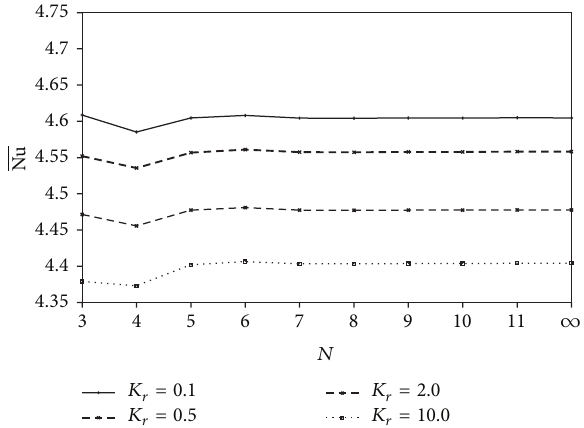
Figure 9: Variation of Nu with 𝑁 for different values of 𝐾 𝑟 at Ra = = 0.5 , and 𝐴 = 𝜋/25 . 10 5 , 𝑋 0